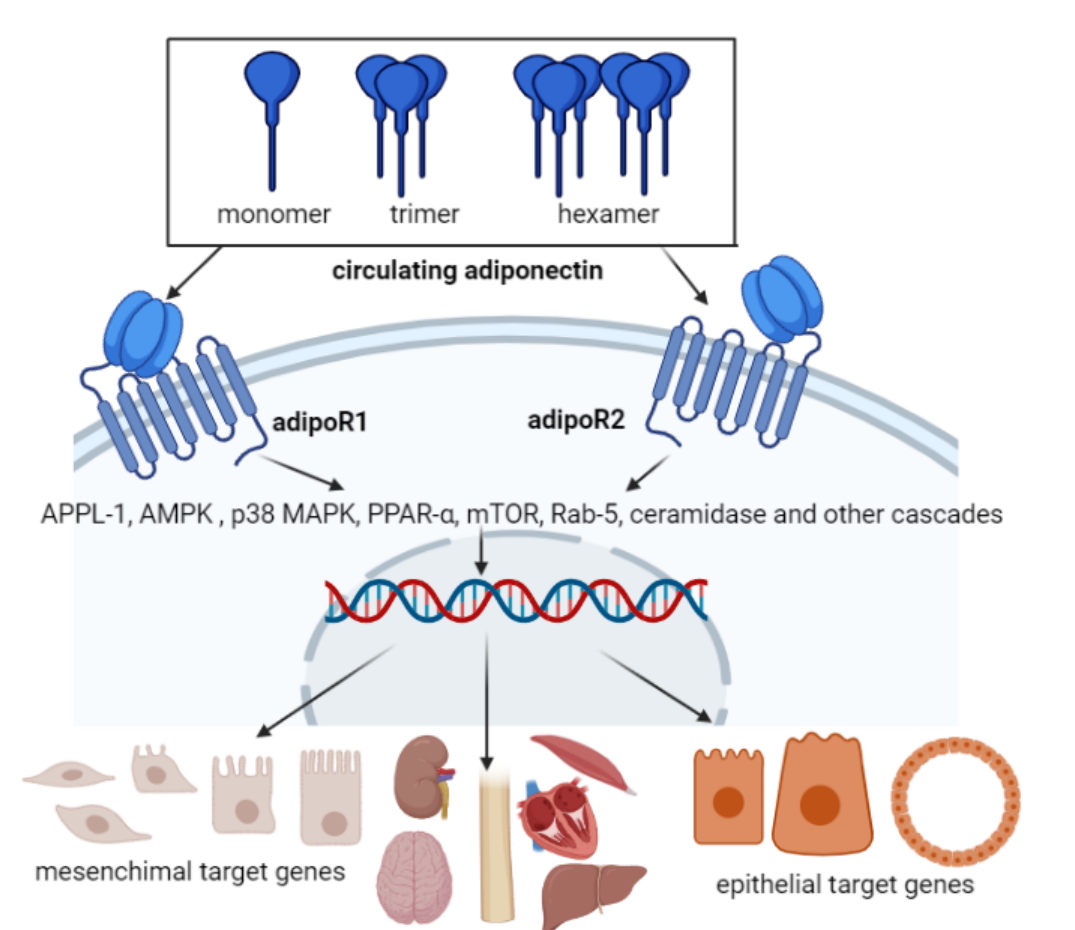
Figure 2. Adiponectin and its receptors and schematic representation of adiponectin-induced signaling pathway. Adiponectin interacts with the C-terminus (carboxyl end) of receptors, which interacts with the protein-adaptive protein (APPL1) in most of the seven regions with its intramuscular N terminus. T-cadherin is a receptor with a high affinity for high molecular weight adiponectin (HMW) isoforms, leading to a complex cascade of events .